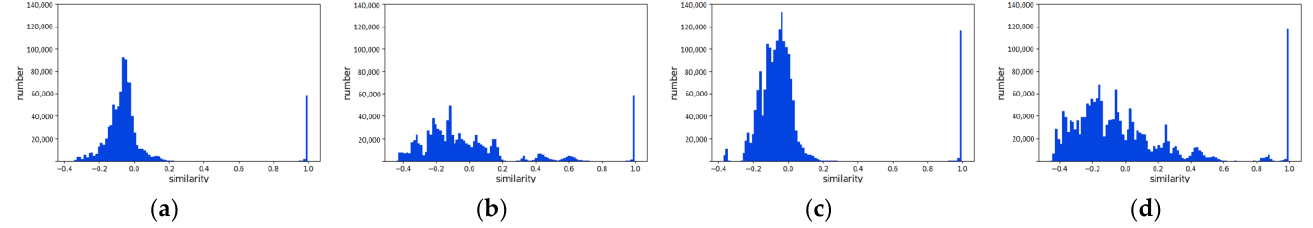
Figure 14. Distribution of similarity over the Houston dataset, when epoch = 300: ( a ) 𝑇 = 0.25, ℎ = 10; ( b ) 𝑇 = 1.0, ℎ = 10; ( c ) 𝑇 = 0.25, 𝑘 = 20; ( d ) 𝑇 = 1.0, ℎ = 20.